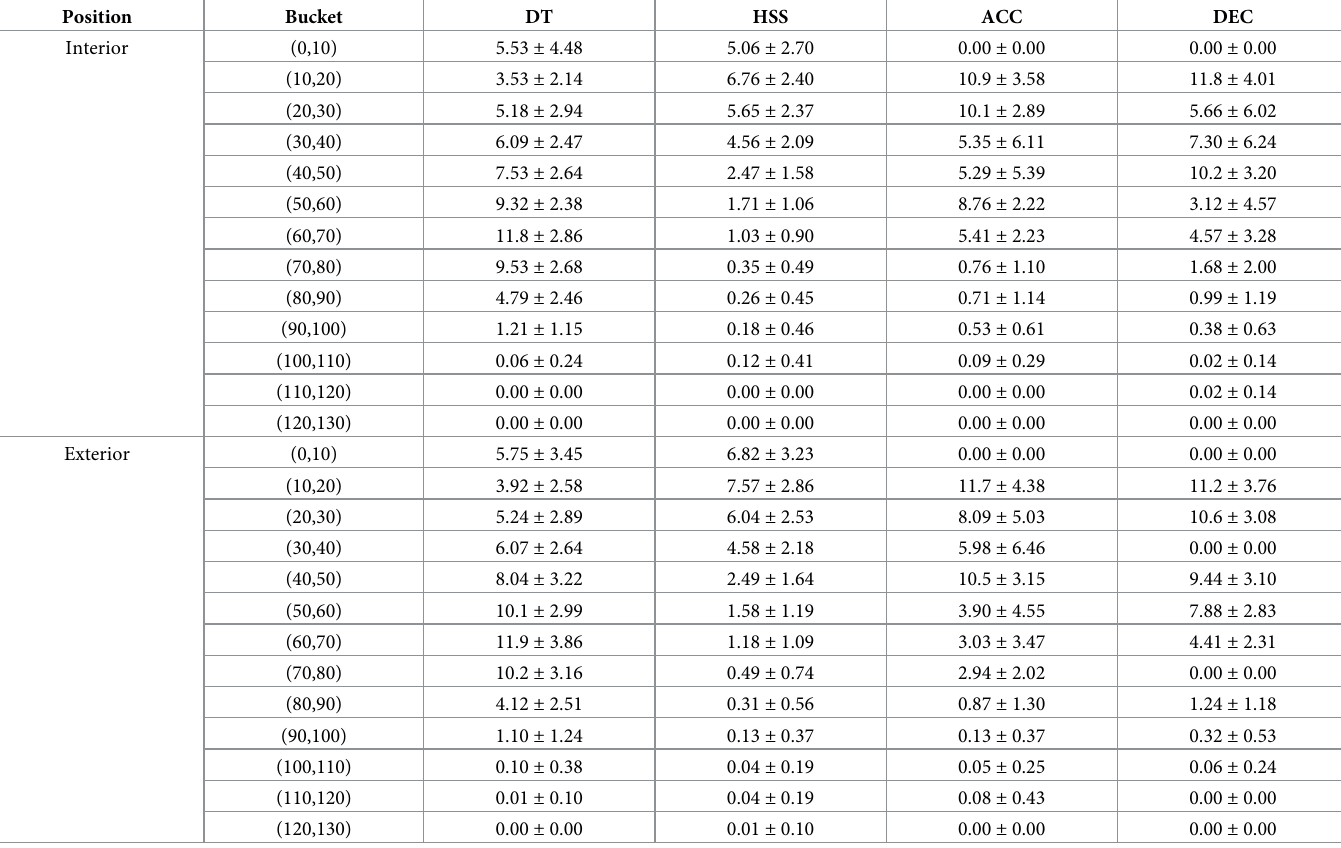
Table 3. Descriptive results of the repetitions number of 30 s scenarios by interior and exterior players for each bucket and variable per match. Position Bucket Interior